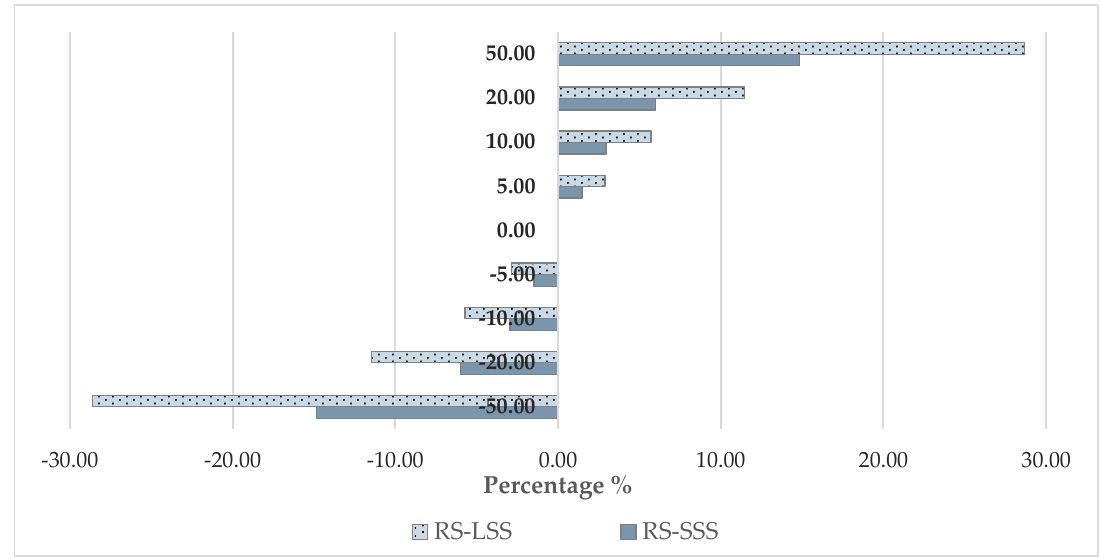
Figure 10. Sensitivity analysis—total cost vs. purchase price (RS—Robotic System; SSS—Small-Scale Scenario; LSS—Large-Scale Scenario).